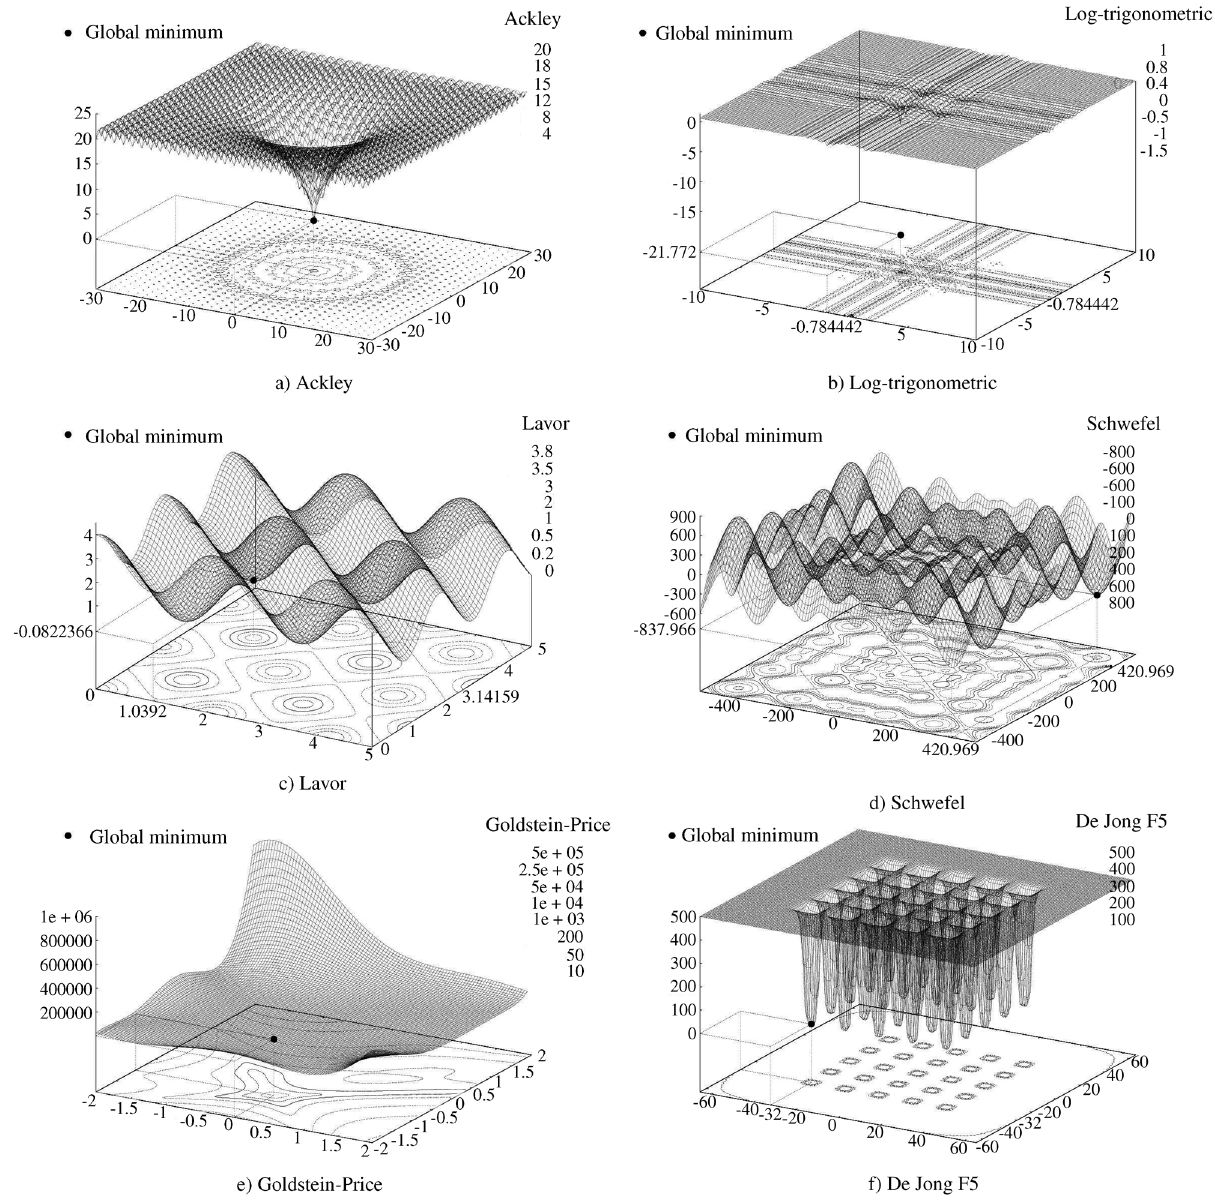
Figure 1 - Test functions used in this